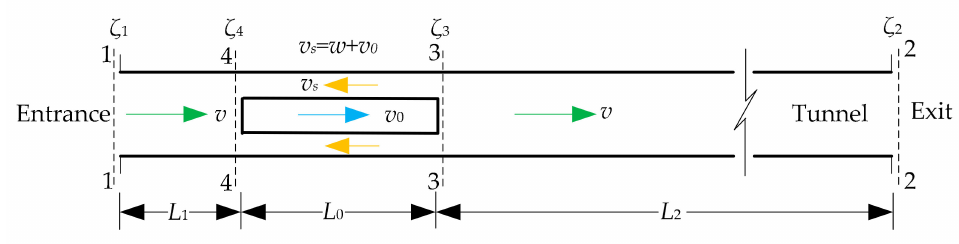
Figure 3. Schematic of uniform